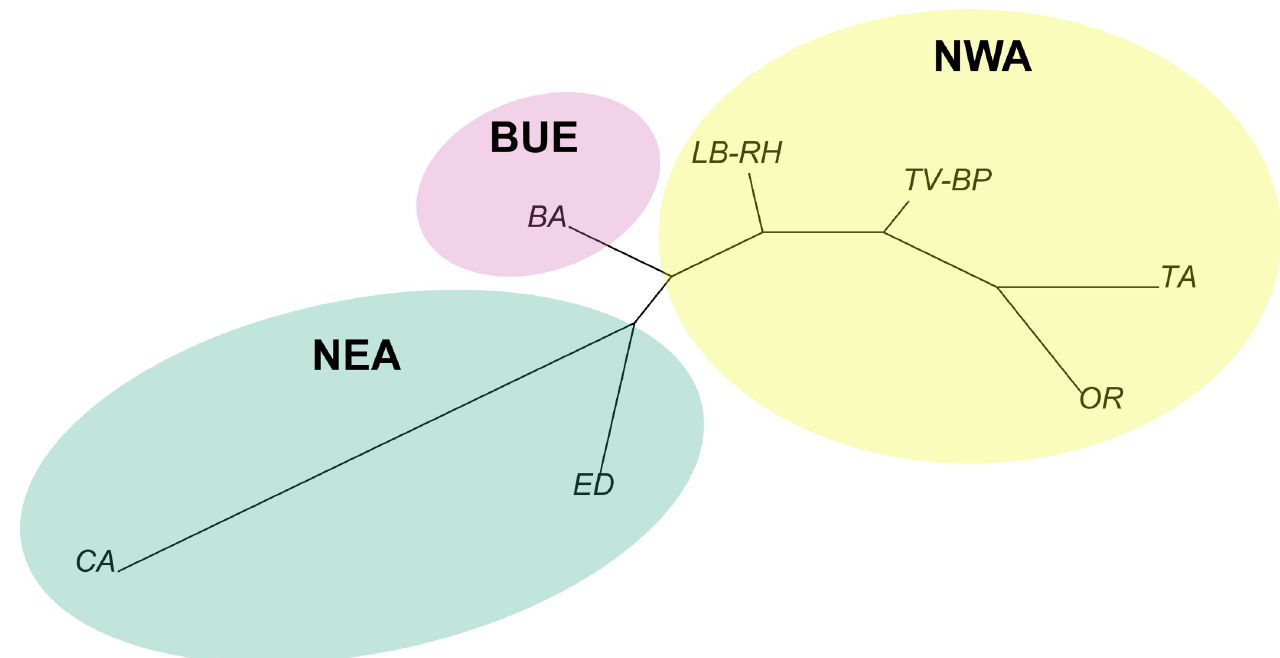
Fig 6. Unrooted Neighbor-joining tree for Ae . aegypti specimens collected in different regions of Argentina. The tree was constructed using a genetic distances matrix (Nei’s F ST as implemented in R package